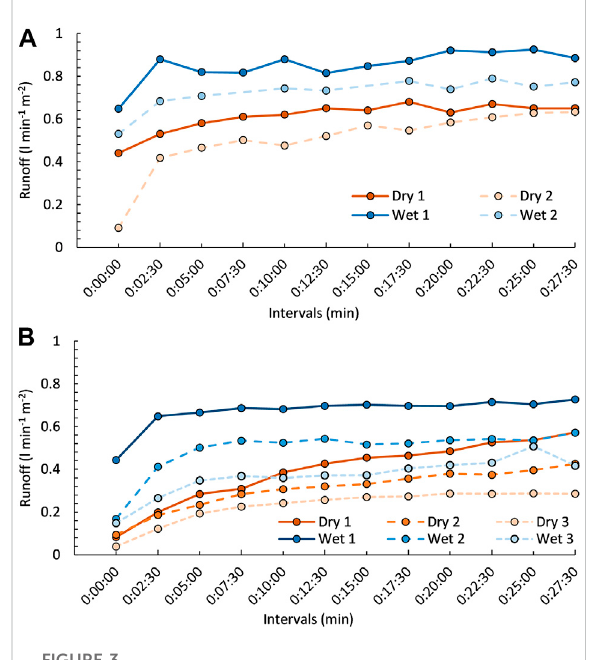
FIGURE 4 Soil loss using different plot sizes: (A) small plots and (B) large plots, under dry and wet moisture conditions. The time axis provides the relative time from the start of the surface